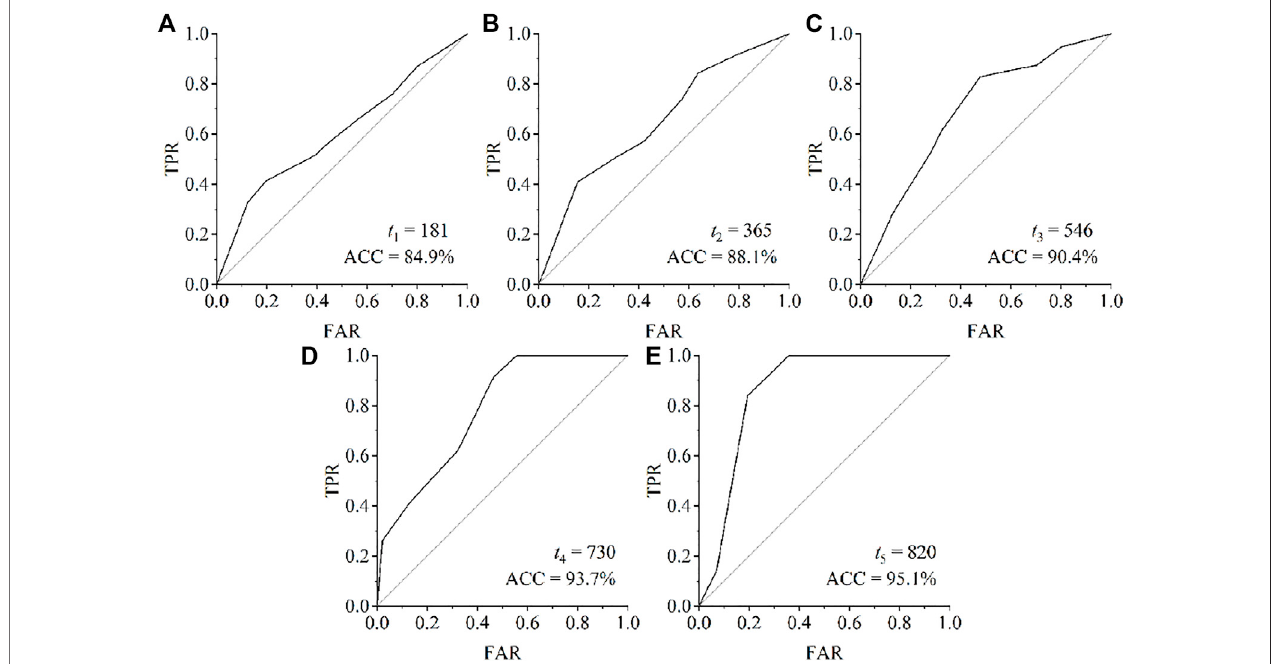
FIGURE 5 | ROC curves for the evaluation of the TSRNN training effects at the fi ve selected time markers based on the 918 training samples.